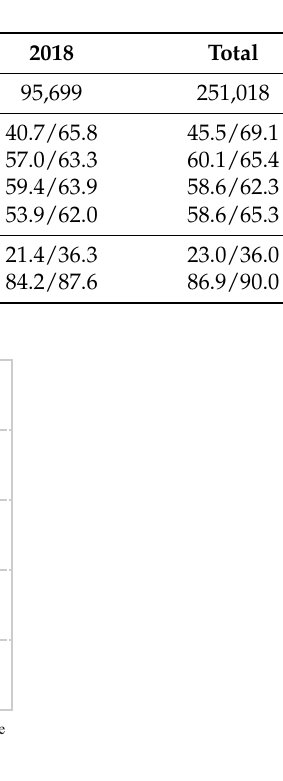
Figure 7. Total percentages of tweets classified as relevant by each of the classifiers, by all classifiers and by at least one classifier for the original tweets and remove keywords . The average for the variants is marked with a black